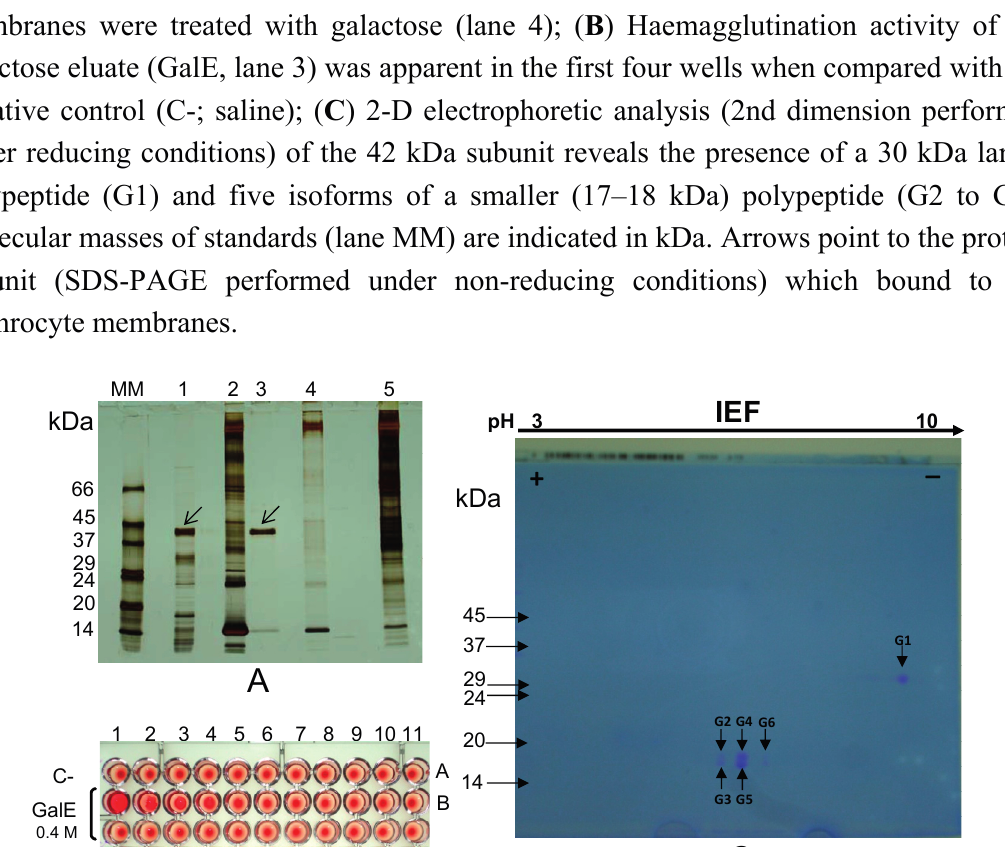
Figure 1. ( A ) NR-SDS-PAGE. The albumin fraction from L. albus seeds (lane 1) was incubated with erythrocyte membranes (lane 2). A 42 kDa subunit was eluted with 0.4 M galactose (lane 3) leaving behind a final membrane fraction (lane 5). Control erythrocyte membranes were treated with galactose (lane 4); ( B ) Haemagglutination activity of the galactose eluate (GalE, lane 3) was apparent in the first four wells when compared with the negative control (C-; saline); ( C ) 2-D electrophoretic analysis (2nd dimension performed